Question: Is the quantity shown trending increasing or decreasing?
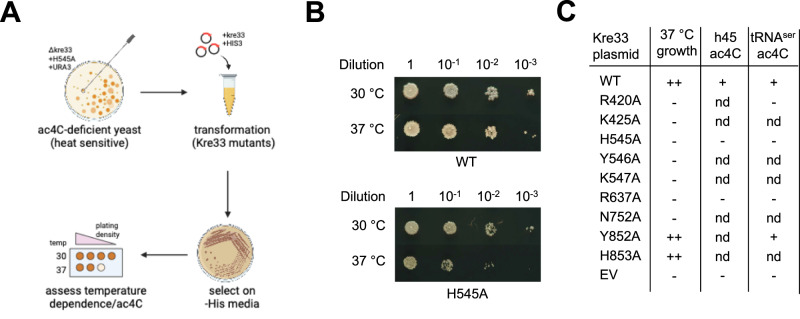
Answer: increasing